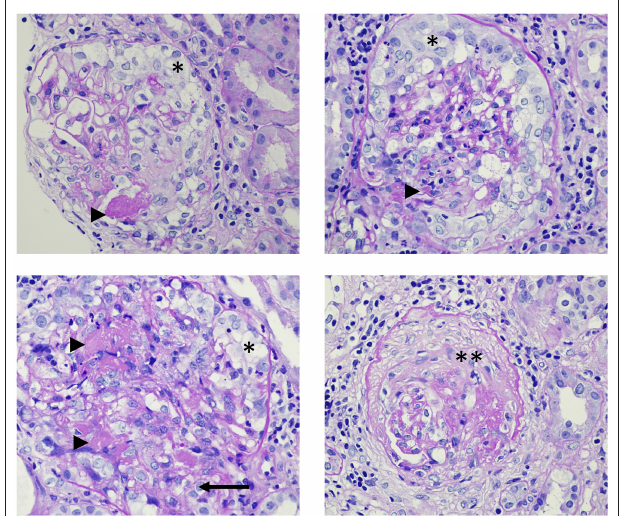
FIGURE 2 | Histopathology images from the renal biopsy of a patient with ANCA-associated glomerulonephritis. The patient has renal limited vasculitis with anti-myeloperoxidase positivity, causing rapidly progressive glomerulonephritis syndrome. Arrowheads: fibrin; *: cellular crescents; **: sclerotic crescent; arrow: rupture of the Bowman’s capsule. Light microscopy, Periodic Acid-Schiff (PAS) staining, magnification: